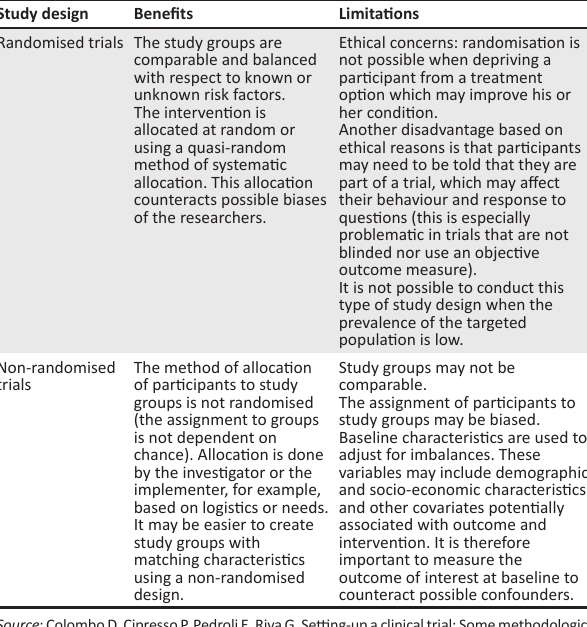
TABLE 3: Benefits and limitations between randomised vs non-randomised trials. Study design Benefits